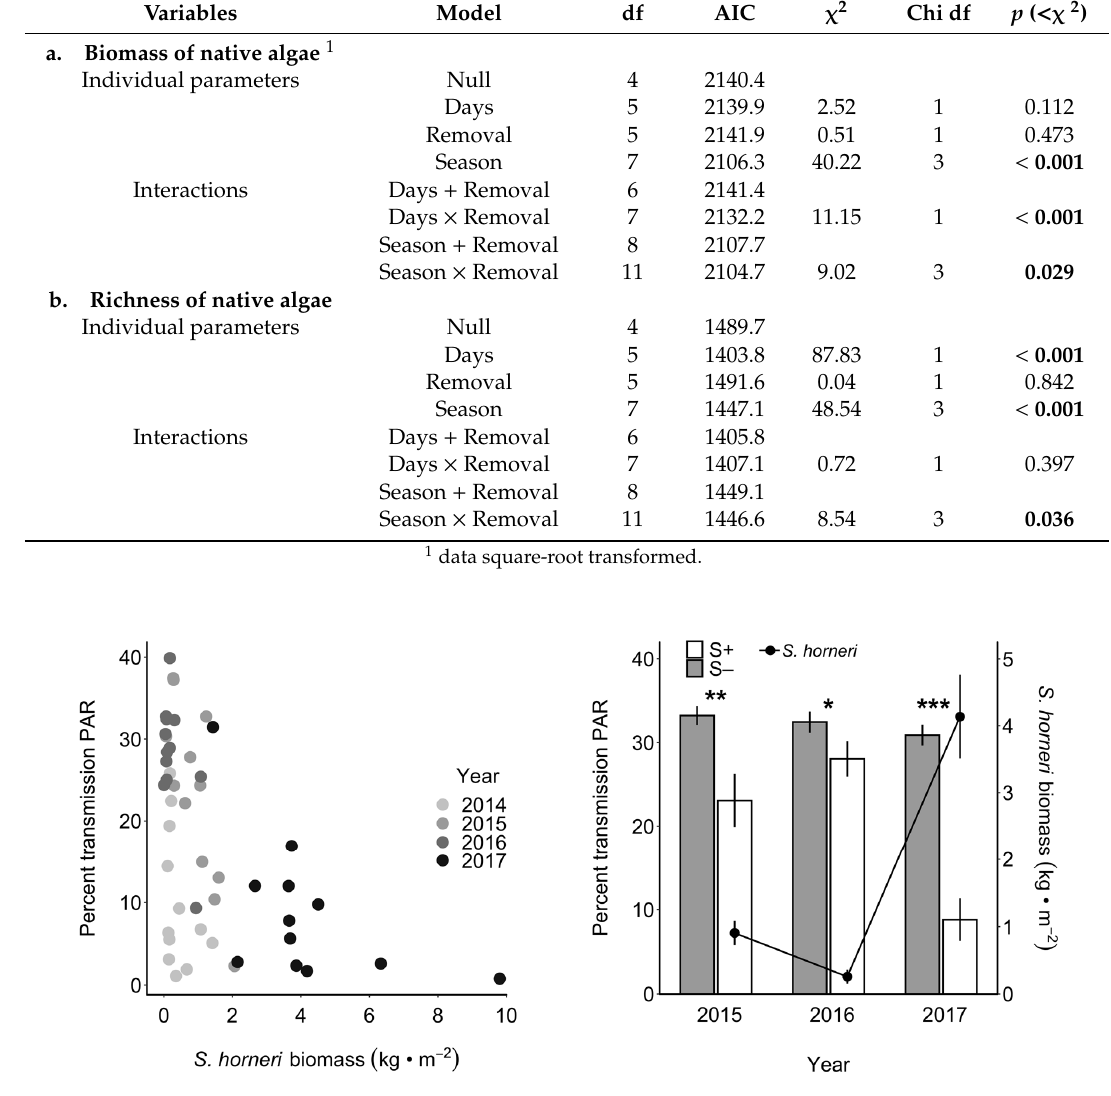
lower AIC values indicating a better fit of the data. Significance was based on chi-square test statistics. Statistically significant p -values are in bold text.